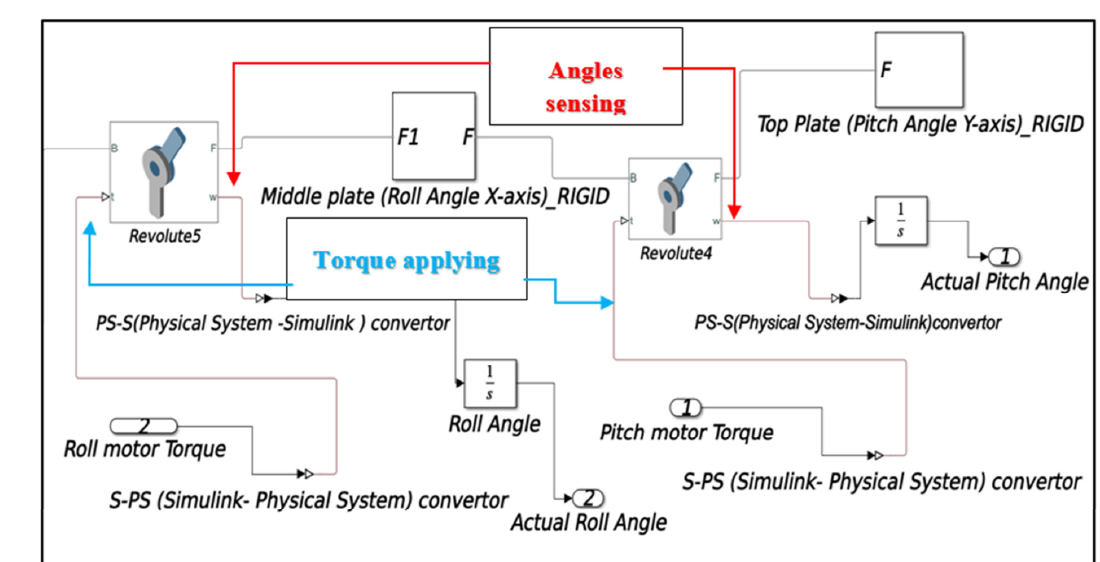
Fig. 9. Torque applying technique and angles sensing